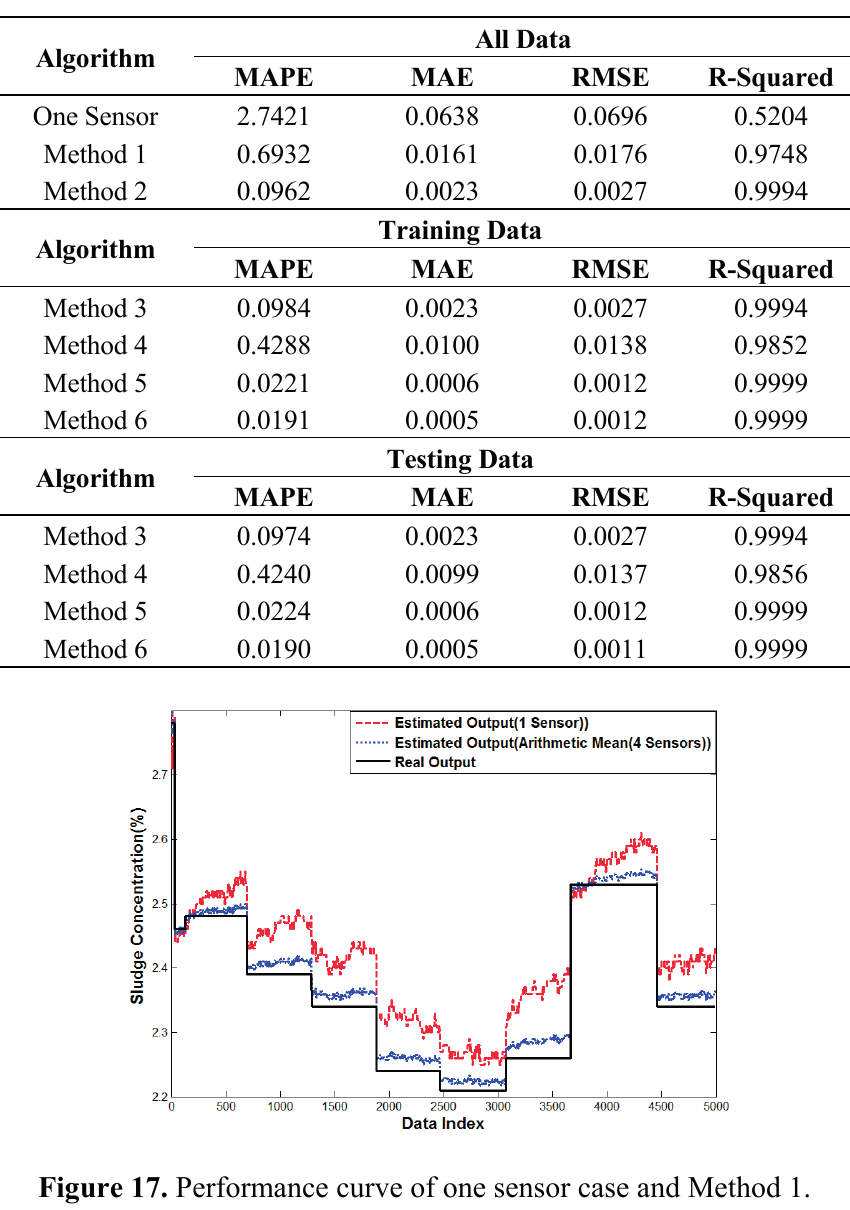
Table 6. Experiment result by WTP Sludge (WTP).